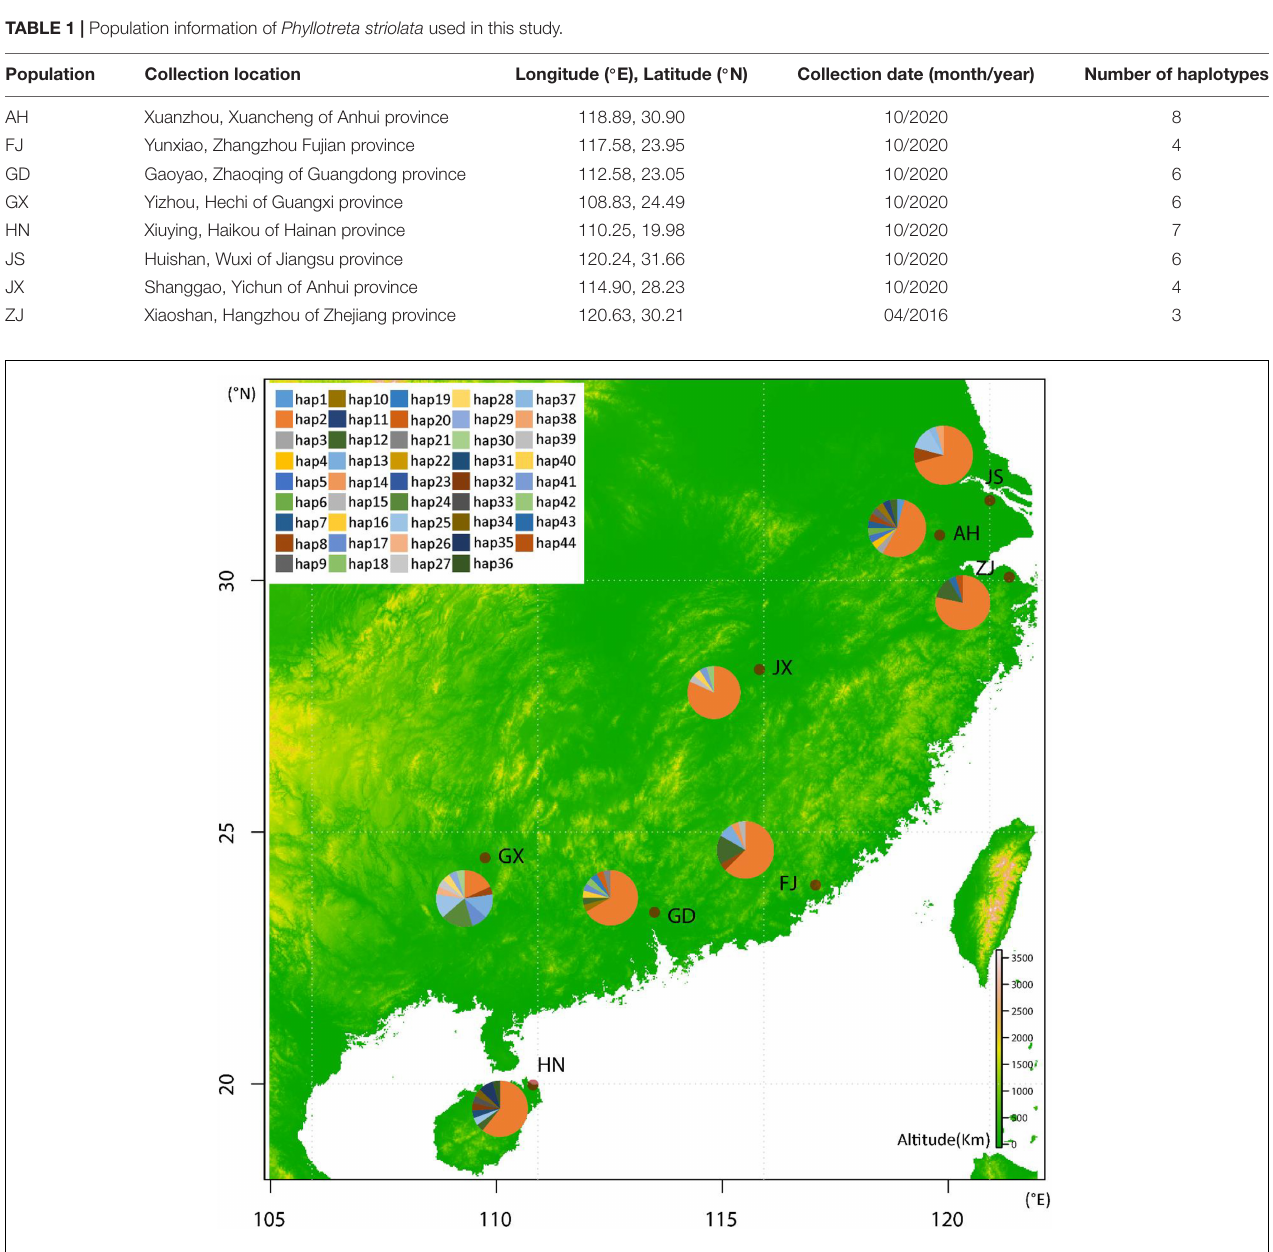
FIGURE 1 | Collection sites and geographical distribution of the mitochondrial cox1 haplotypes of Phyllotreta striolata . The haplotype frequency for each population is represented by colors in the pie charts. See Table 1 for population